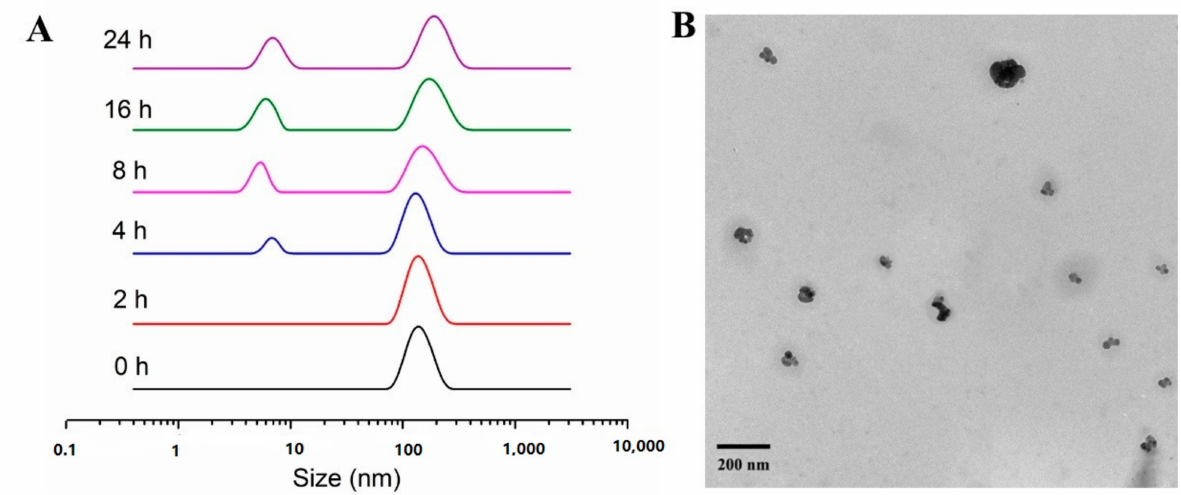
Figure 5. Size distribution ( A ), and TEM image ( B ) of P1 after treatment of